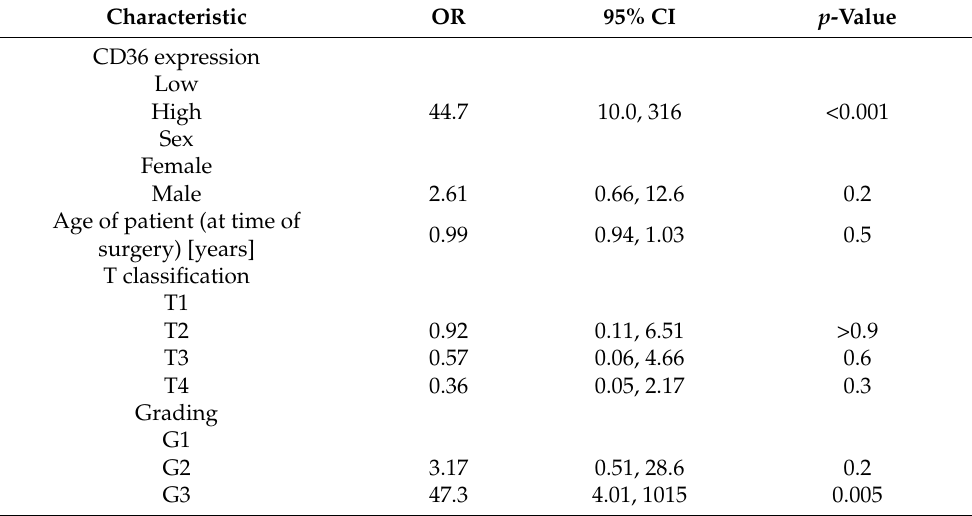
Table 3. Cross-table showing the association between CD36 expression and lymph node metastasis. N Stage Total N0 N+ Low 37 8 45 CD36 High 6 32 38 Total 43 40 83